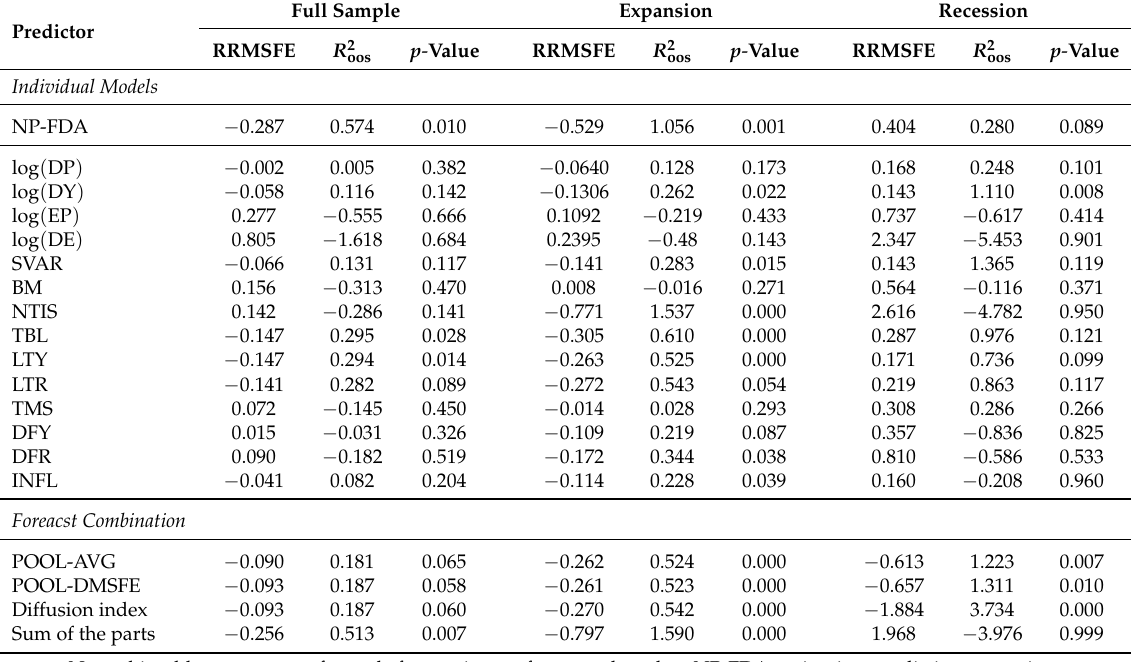
Table 2. Out of sample forecasting evaluation of Dow Jones Industrial Average (DJIA) excess return based on NP-FDA and regression